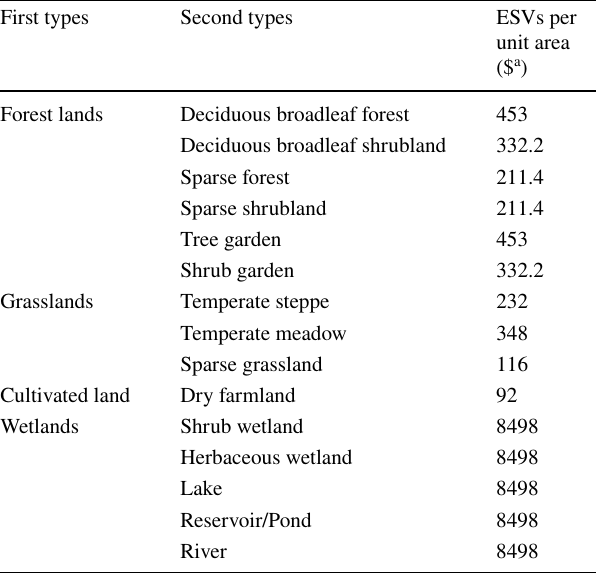
of the evapotranspiration of different landscapes in Ejina Oases